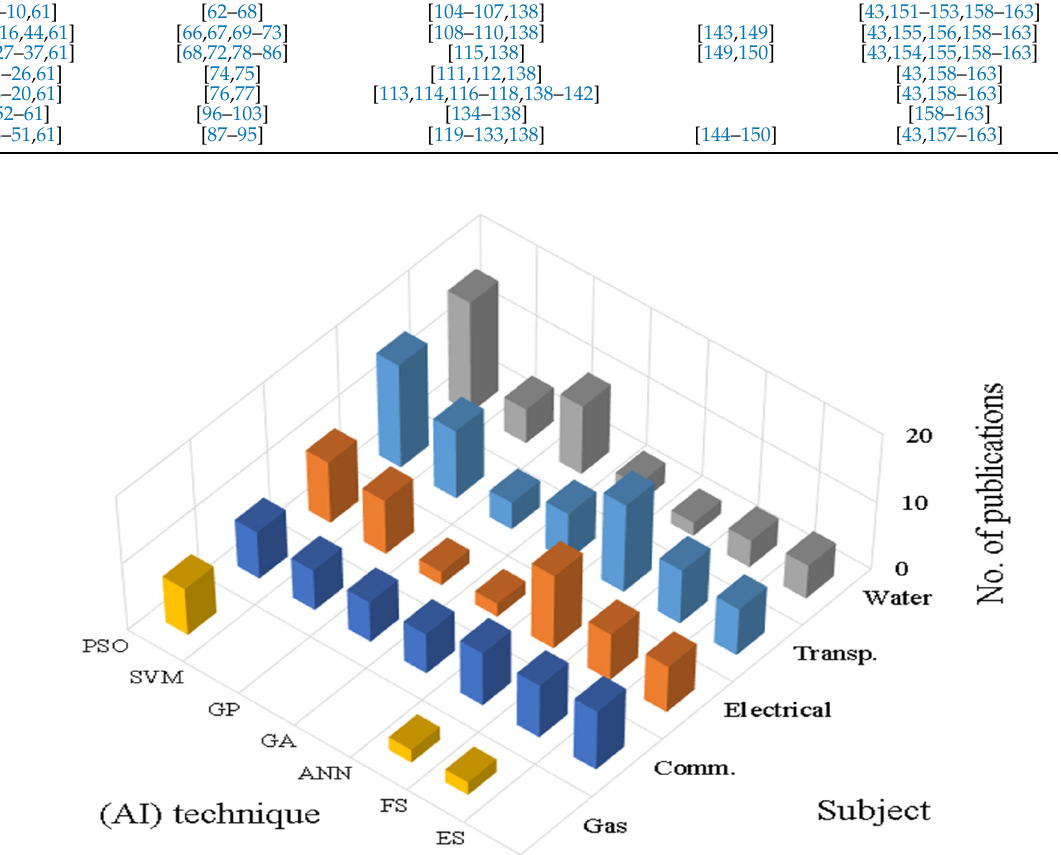
Figure 19. No. of publications for each considered subject and each considered AI technique.